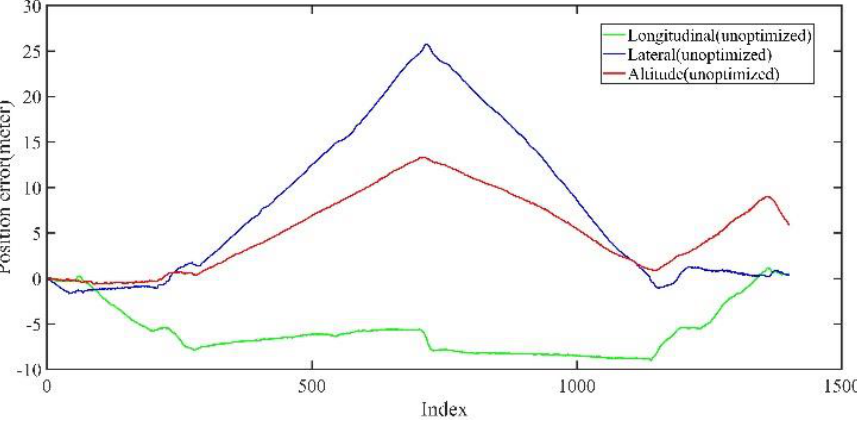
Figure 17. Large scale scenario unoptimized mapping trajectory position error in longitudinal, lateral, and altitude directions. Before optimization, the error is at the meter level.